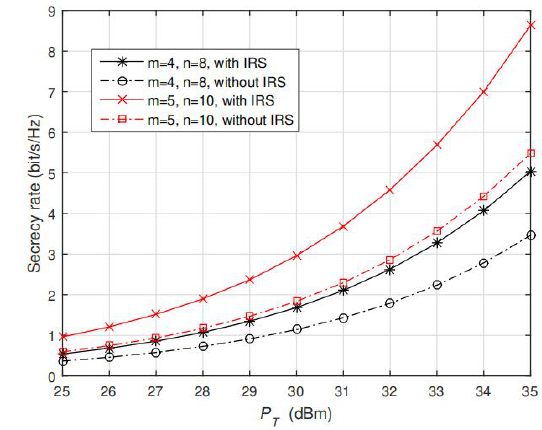
Figure 5. Average secrecy rate of IRS-assisted case using AO algorithm and no-IRS case using optimal solution in [6] under different settings of m = 4,5 and n = 8,10. P T is fixed at 30